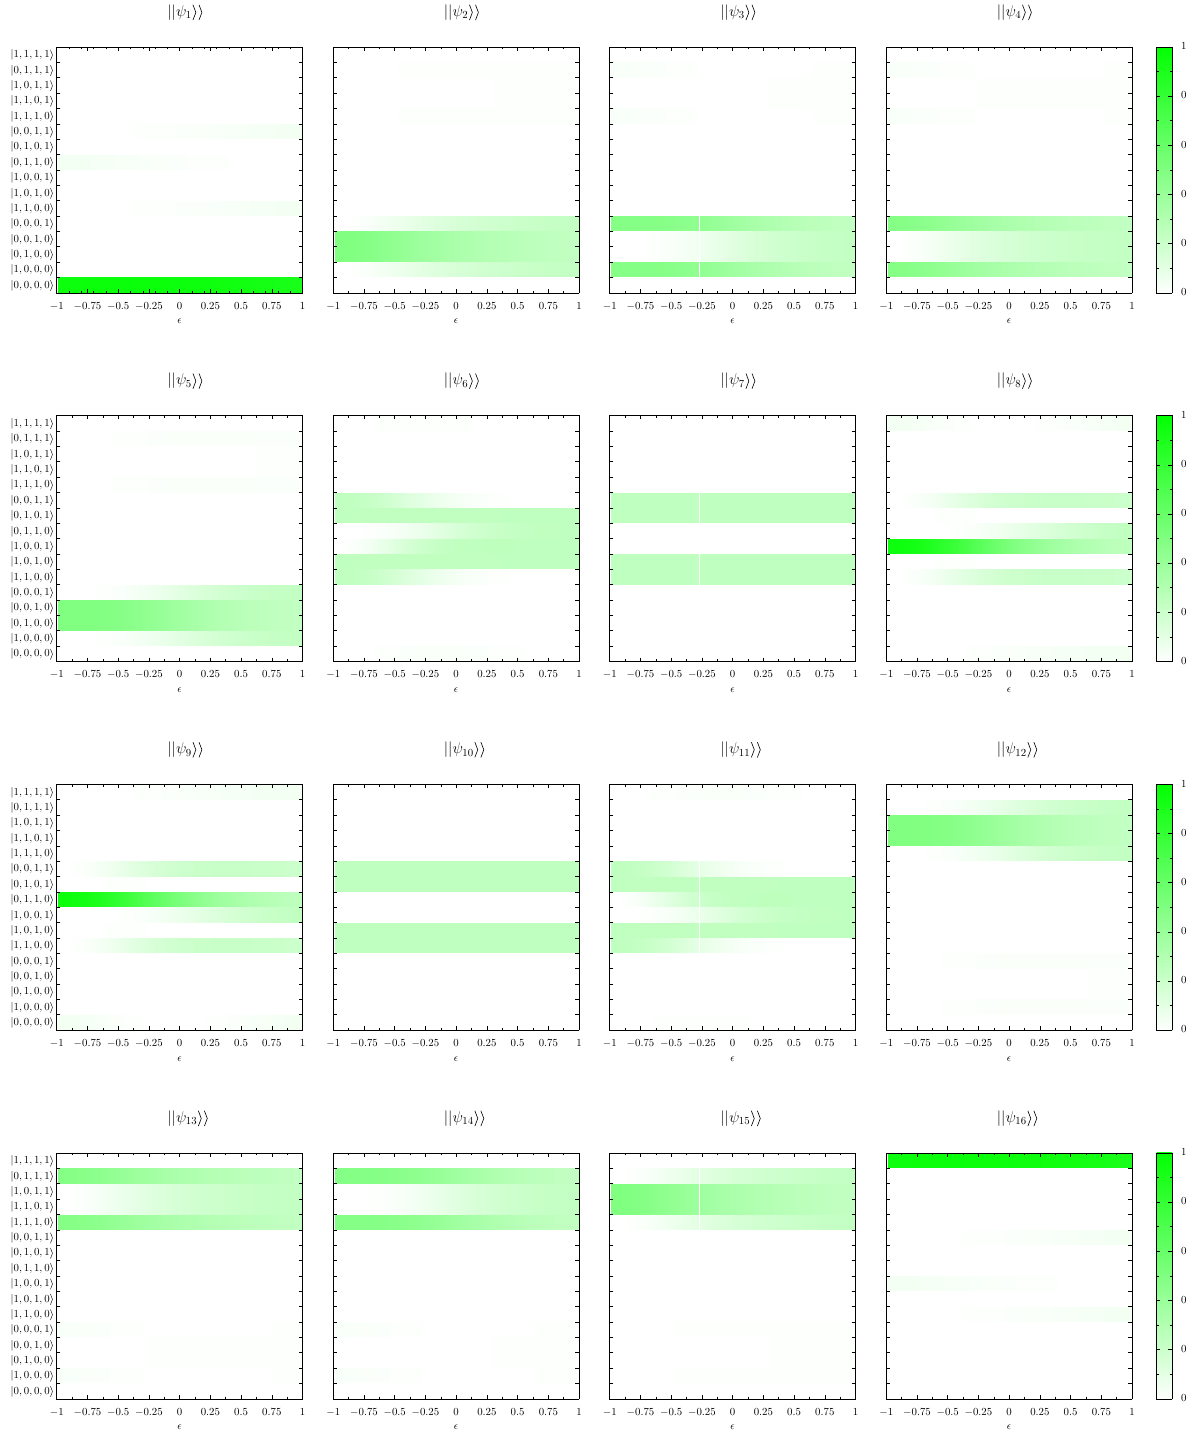
Figure 4. Eigenstates in the dimerized chain. The probability densities of the eigenstates ultrastrong coupling regime, in terms of the bare states In the figure, the coupling strength ¯ J dimensional Hilbert space). The presented eigenstates correspond to the eigenfrequencies of Fig.